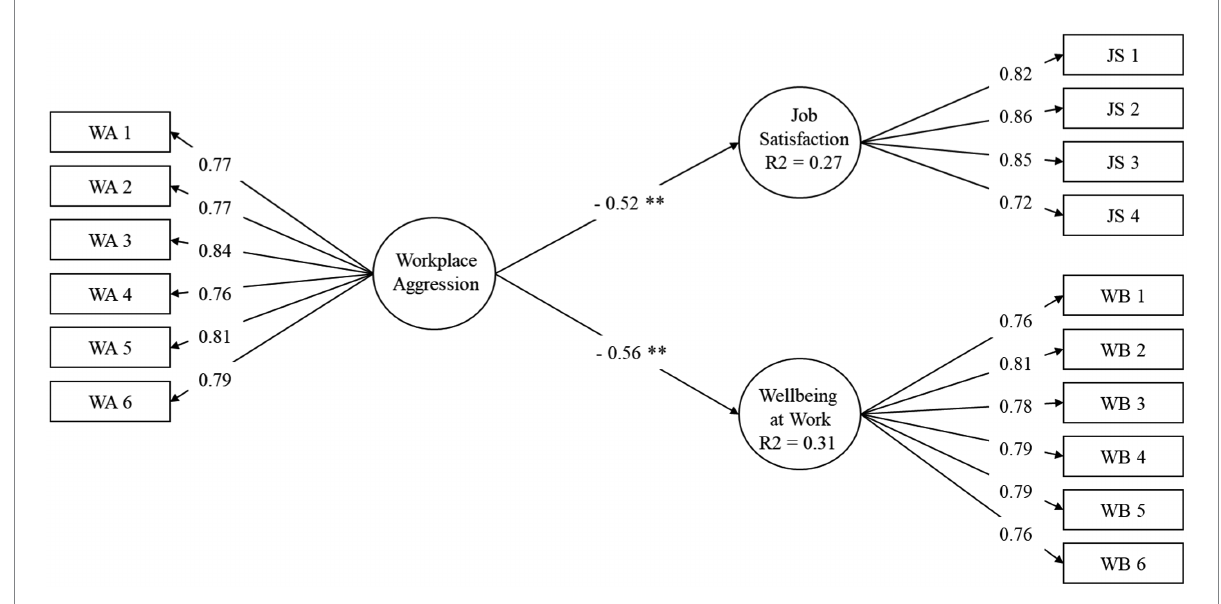
FIGURE 3 Effects of the Workplace Aggression on Job Satisfaction and Wellbeing at